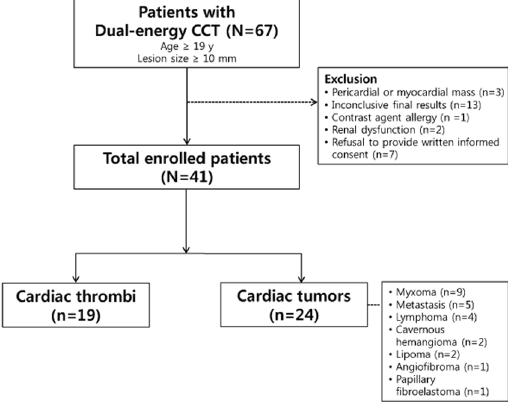
Figure 5. A flow diagram of the patient selection